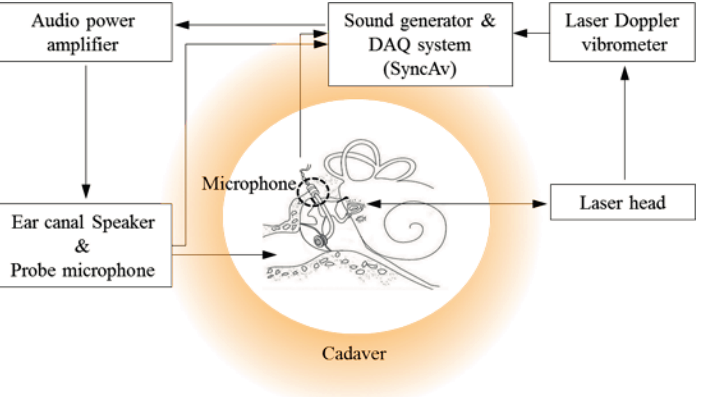
Figure 3. Block diagram of cadaveric temporal bone experiments for in situ verification of the proposed trans-tympanic microphone performance.